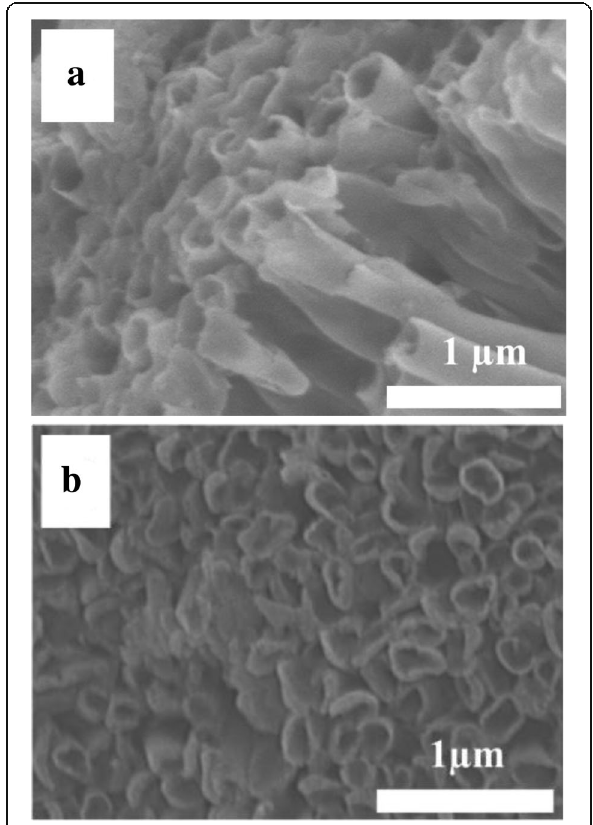
Fig. 1 SEM images of obtained TNTs from the side ( a ) and top ( b ) view